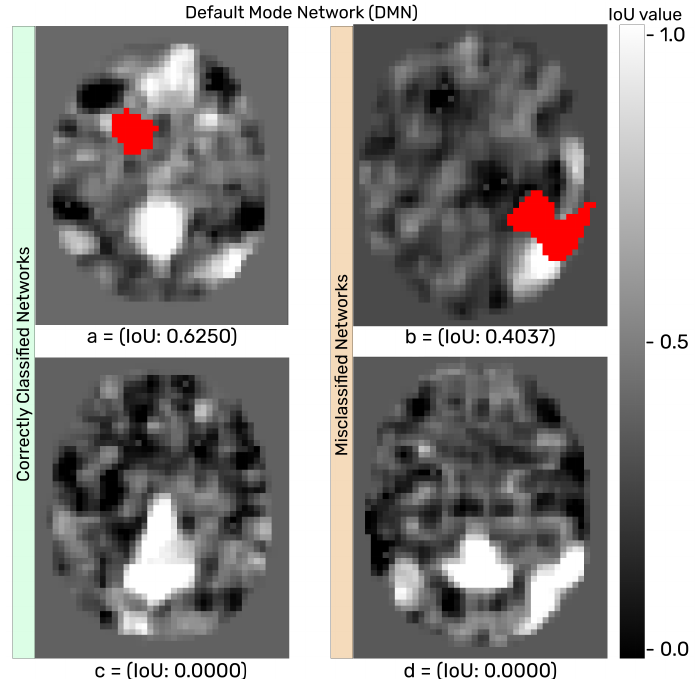
Figure 11. Visualization of correctly and wrongly classified Images (with and without Overlap)— ( a ) is correctly classified with overlap; ( b ) is wrongly classified with overlap; ( c ) is correctly classified without overlap; ( d ) is wrongly classified without